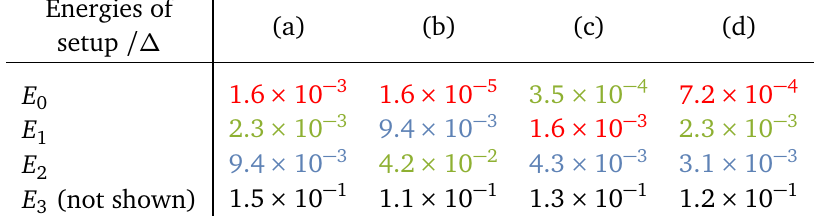
Figure 6: Probability distributions (color) of the ground, second and third lowest energy with (a) all gates (b) gate G chosen so that red wavefunction always has a weight on the left end. The energies for the pairs of Majorana states are given in the table